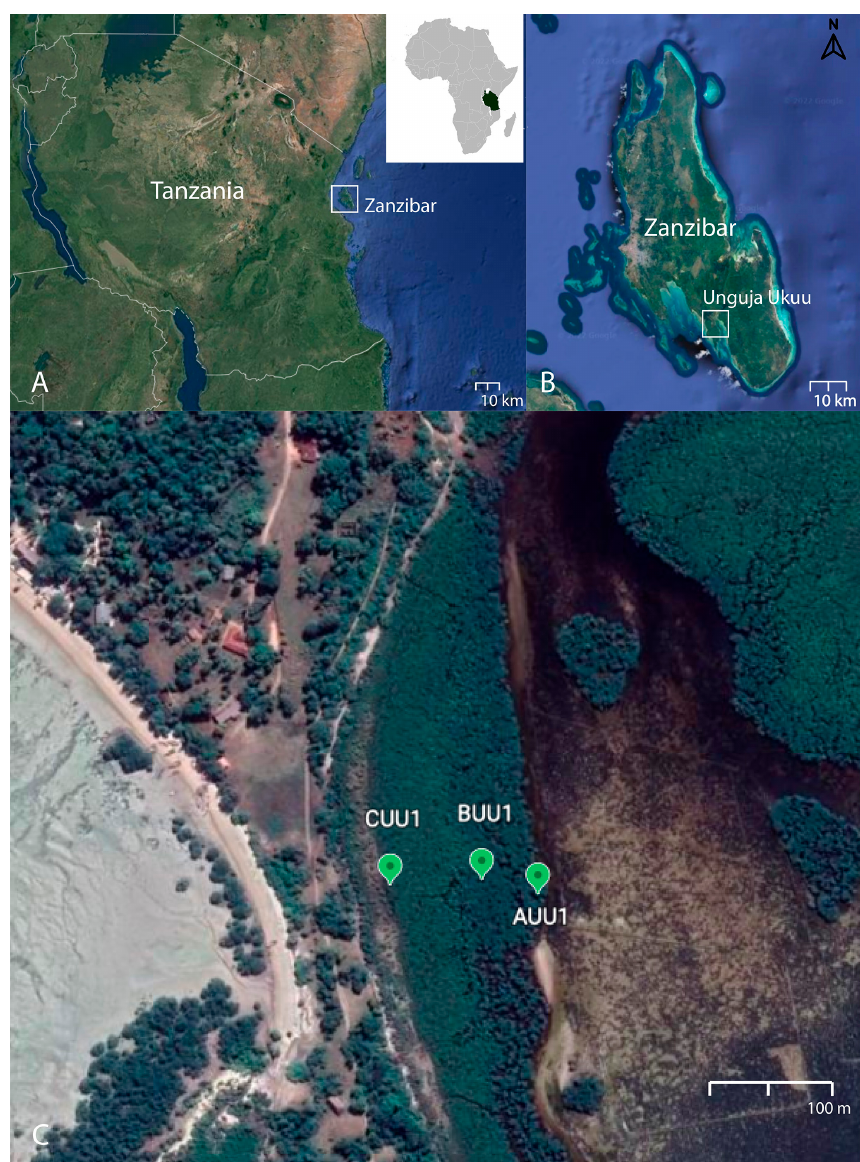
Figure 1. ( A ) Map of Zanzibar Island ( B ) Location of the Unguja Ukuu site showing the location of mangrove coring sites with green spot ( C ).